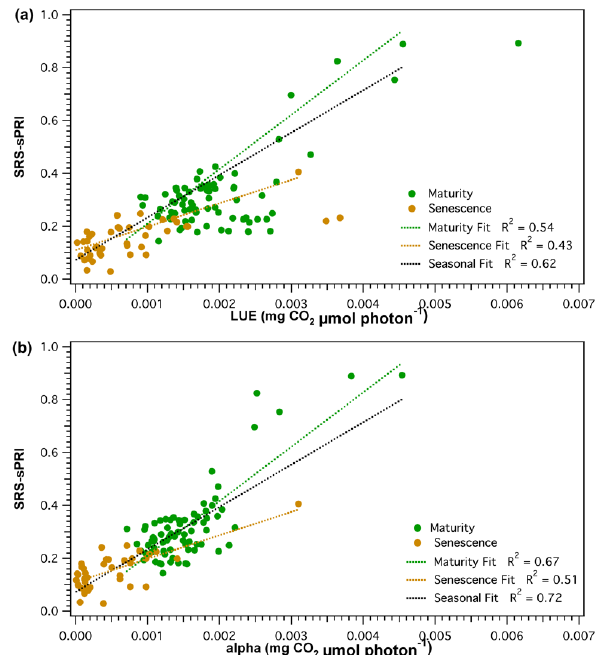
regressions fitted to the data.